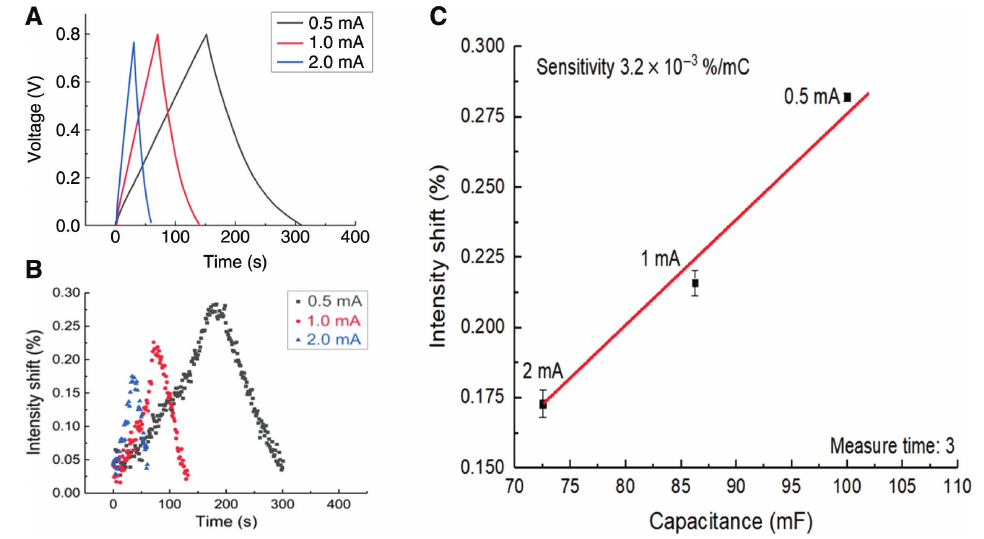
Figure 6: Charge and discharge tests in galvanostatic mode. (A) Galvanostatic charge-discharge curve at different constant current. (B) Real-time intensity shift of fiber-optic LSPR sensors at different constant current in galvanostatic test. (C) Linear fitting curve between the intensity shift (%) in fiber-optic LSPR sensor and calculated